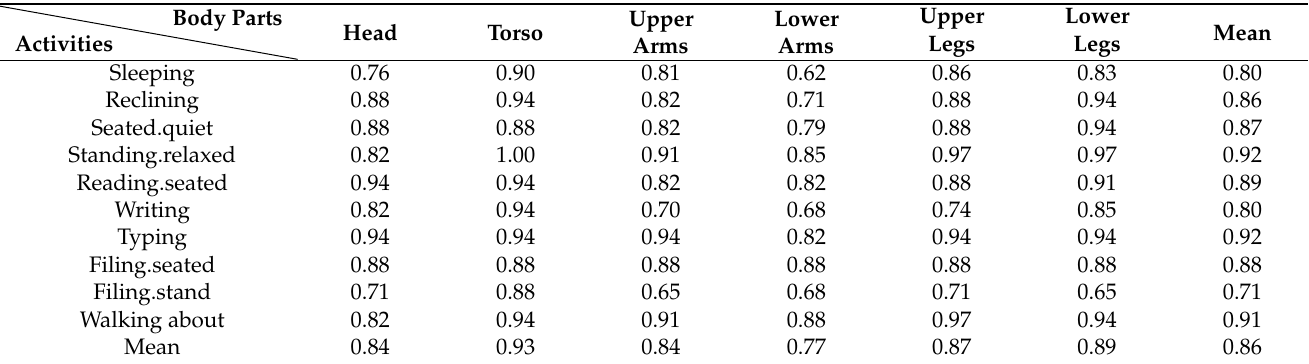
Table 2. PCPs of body parts by indoor